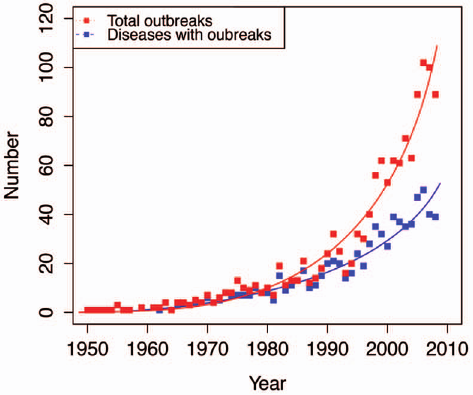
Figure 3. Increase in total outbreaks and total number of infectious diseases causing outbreaks since 1950 in Asia-